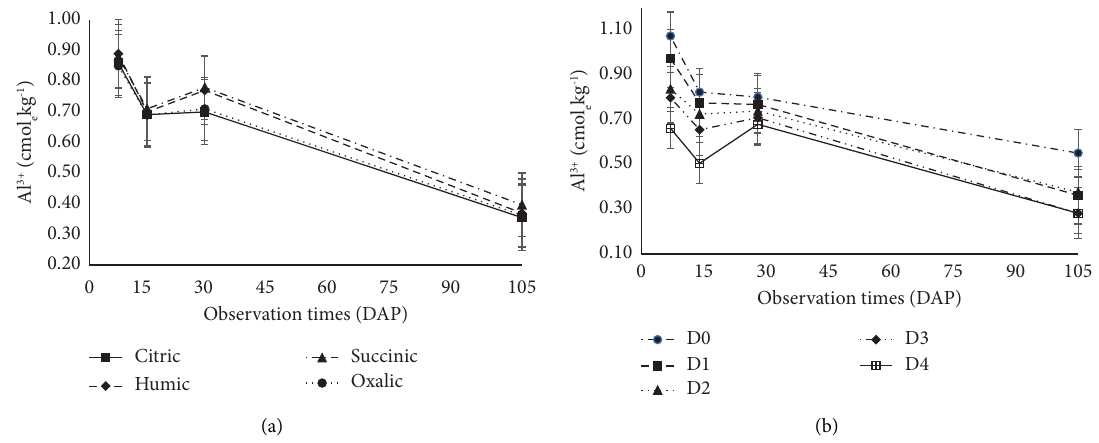
Figure 2: Efect of OA types (a) and OA concentration levels (b) on soil Al 3+ at some observation time.